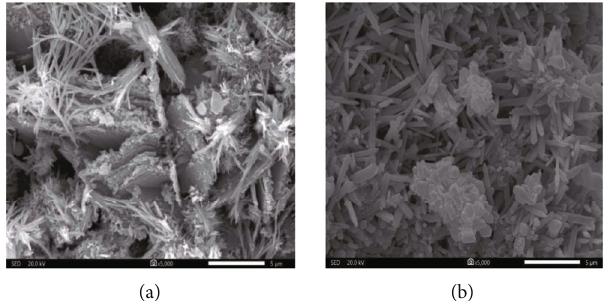
Figure 5: SEM image of 28 d coral sand mortar with 0.00% and 0.03% GO magni fi ed at 5000 times. (a) the dosage of GO is 0.00%. (b) The dosage of GO is 0.03%.